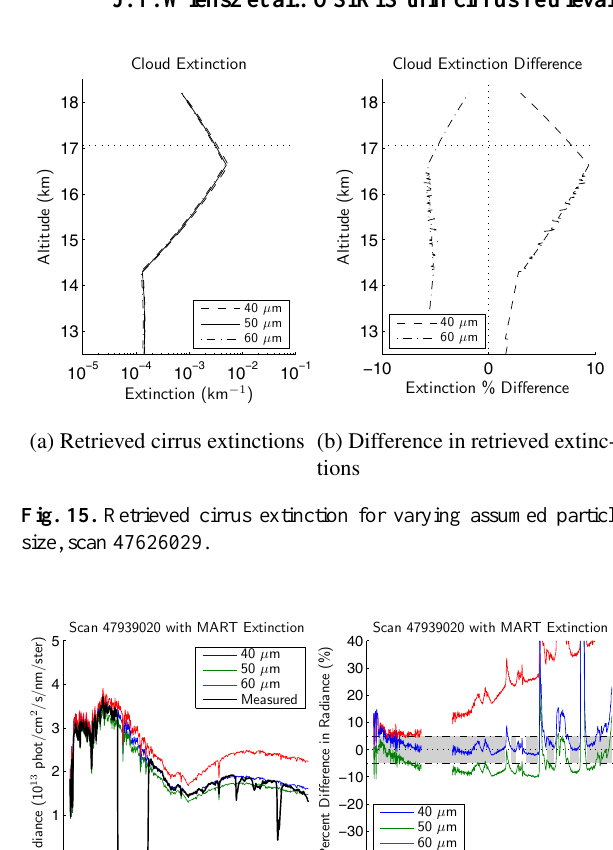
Fig. 16. In-cloud radiances modeled with retrieved extinction pro- Fig. 16: In-cloud radiances modeled with retrieved extinction file for several assumed particle profile for several assumed particle sizes.